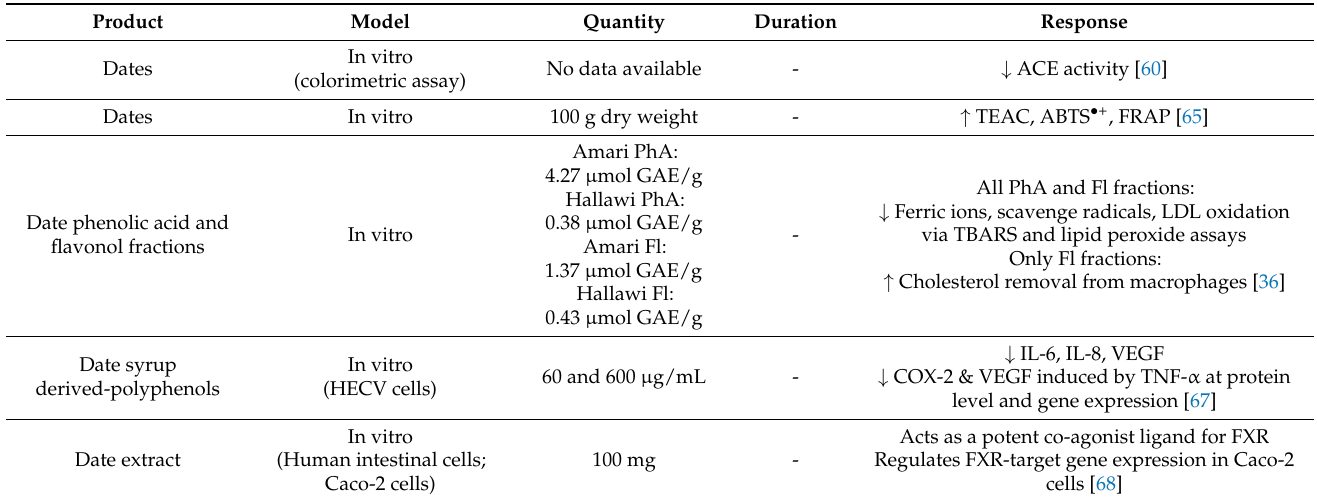
Table 1. Intakes of date palm fruit products and surrogate cardiovascular markers a